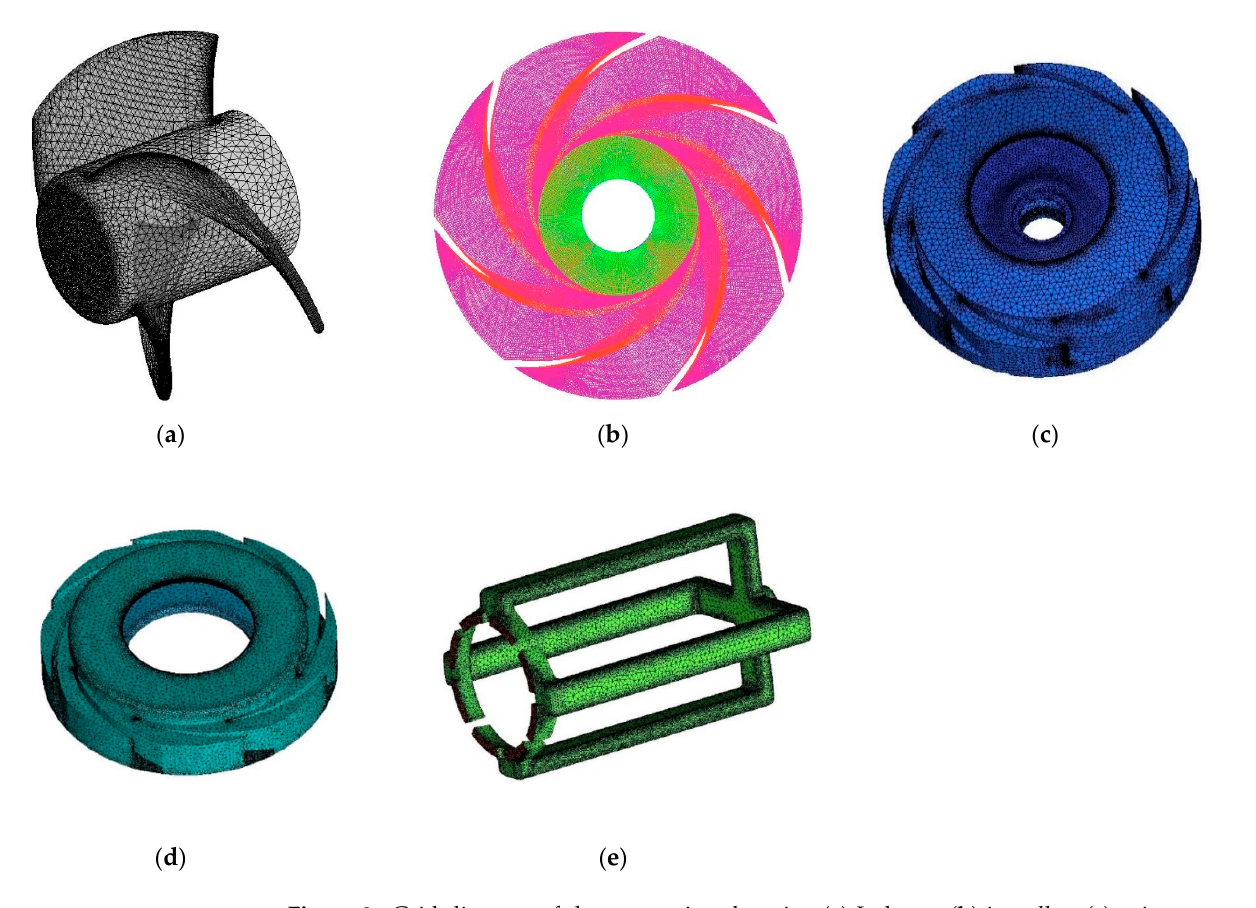
Figure 3. Grid diagram of the computing domain. ( a ) Inducer; ( b ) impeller; ( c ) primary pump cham ‐ ber; ( d ) secondary guide vane and ( e ) outlet pipeline. chamber; ( d ) secondary guide vane and ( e ) outlet